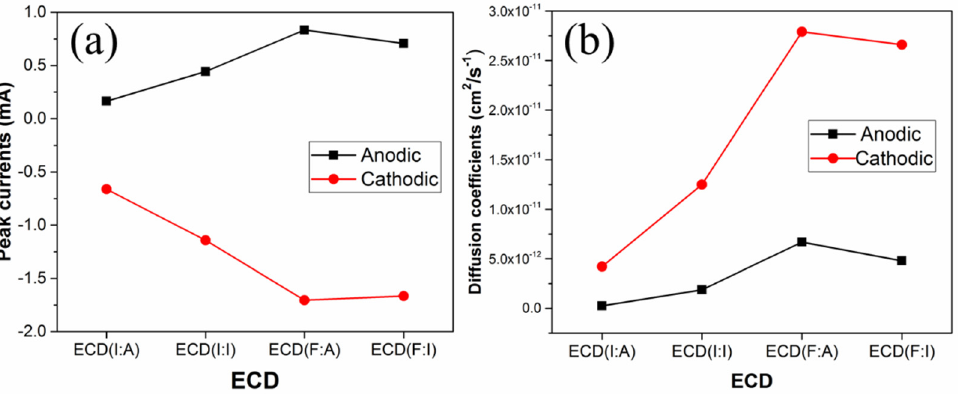
Figure 3. Graphs indicating the anodic and cathodic ( a ) peak currents and ( b ) diffusion coefficients of the ECDs. of the